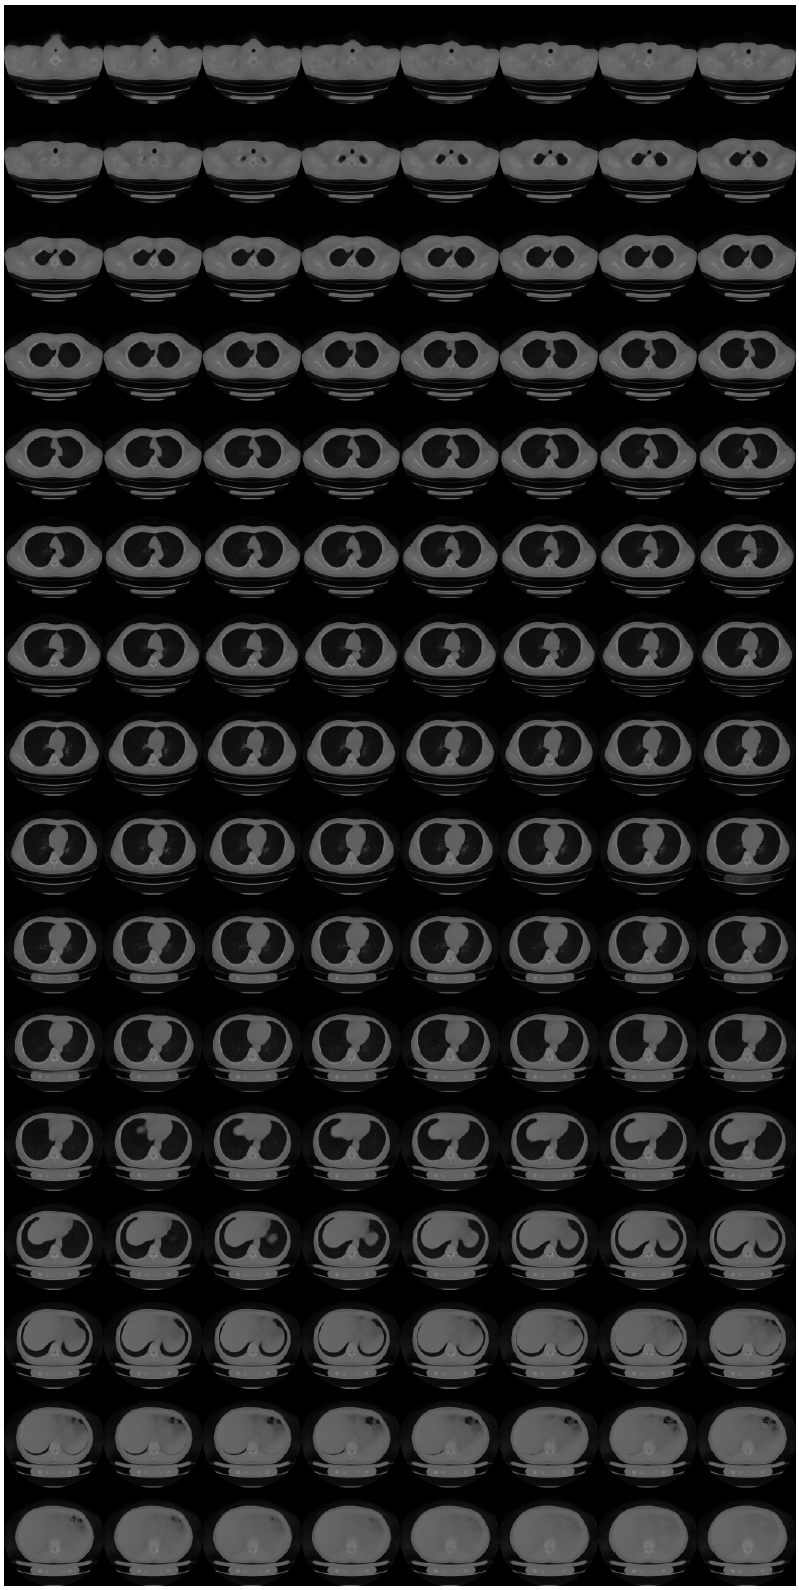
Figure A3. Fictional 3D CT image at the final epochs (sampled with T = 0.5, progressive learning, 1 of